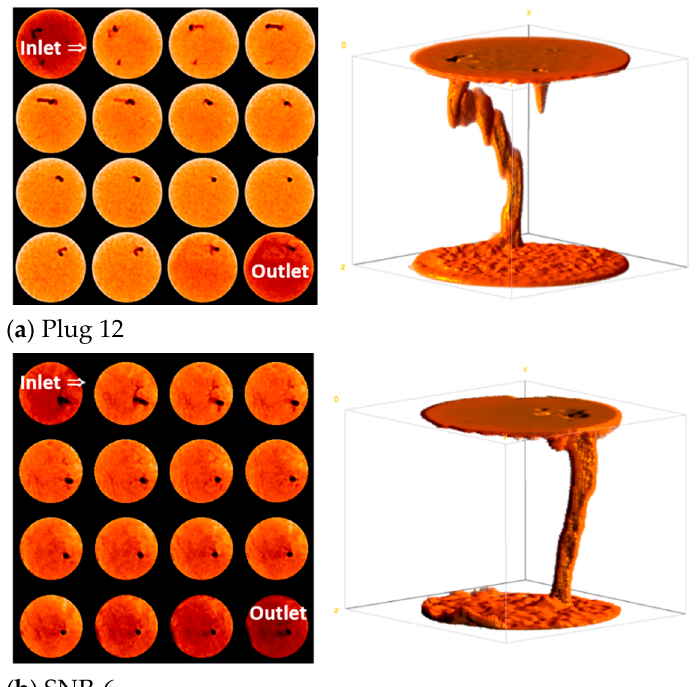
Figure 5. Wormhole-propagation tests ( a ) Core inlet (left); ( b ) outlet (right) after CO 2 foamed acid injection.